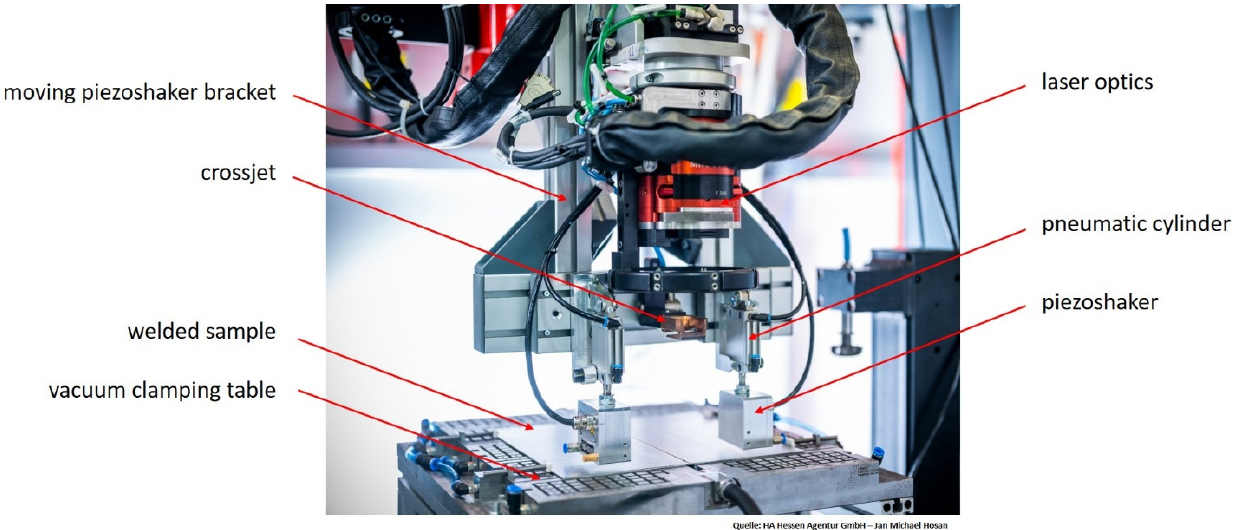
Figure 1. Photographic image depicting an overview of the experimental setup for welding experiments.